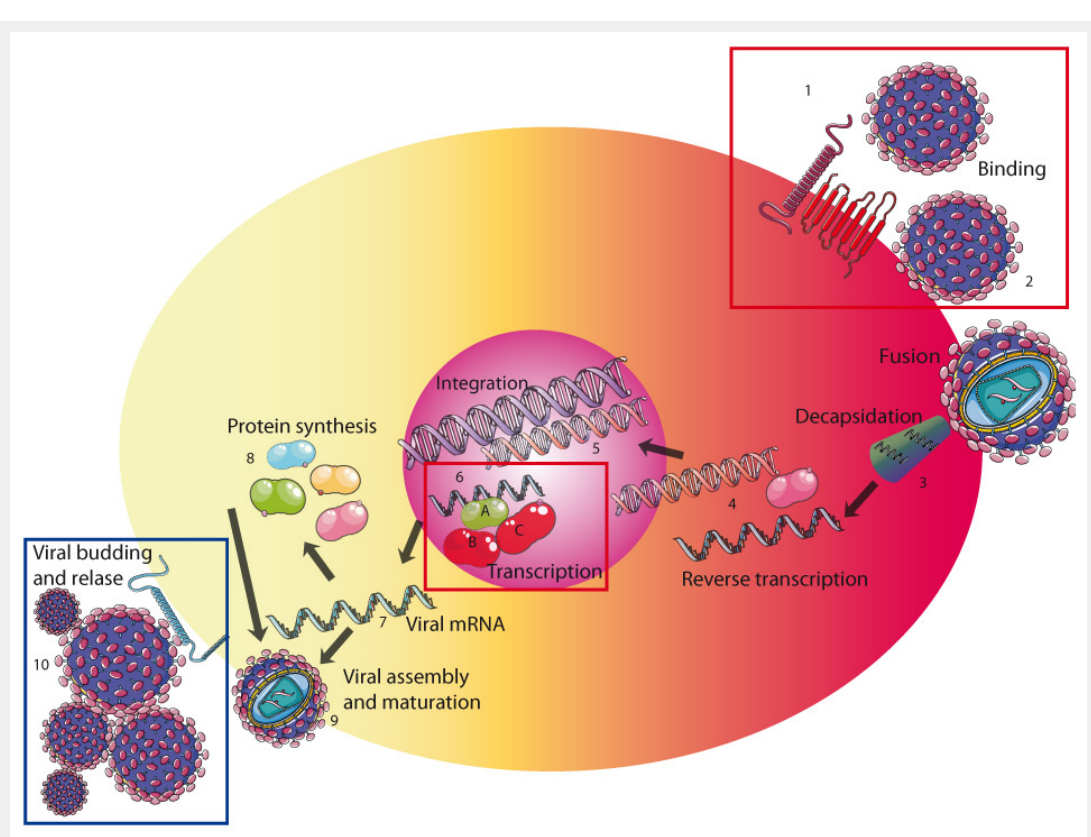
HIV-1 needs critical host factors for efficient replication. HIV binds to the HIV receptor complex of the human CD4 cell-surface molecule and a co-receptor, either CCR5 or CXCR4, via the HIV envelope glycoprotein 120 (HIV env gp120). After conformational changes in the HIV env gp41, viral host cell membrane fusion occurs (2). The next steps are the decapsidation (3) and release of the HIV RNA from the virus particle. Reverse transcription generates a viral complementary DNA (cDNA) based on the viral RNA template and using HIV’s own reverse transcriptase (4). Once the cDNA is generated, the preintegration complex (PIC) is assembled, nuclear trafficking and integration of the viral cDNA into the host genomic DNA follow (5). Efficient transcription and elongation require formation of P-TEFb (positive transcription elongation factor b) consisting of Tat (6A), human cyclin-dependent kinase 9 (CDK-9) (6B) and cyclin T1 (6C), which binds to the nascent HIV transcripts. Fully or partially spliced HIV mRNA (7) is used to translate viral proteins. Unspliced HIV RNA is packaged into newly generated virions. Assembly of HIV proteins and RNA and budding take place at the cellular membrane (9). HIV release is inhibited by murine tetherin at the cellular membrane because murine tetherin is insensitive to the viral protein Vpu, which inhibits human tetherin by directing its proteasomal degradation (blue frame). Human host factors critical for HIV replication are CD4, CCR5, CXCR4 and cyclin T1 (red frame). Additional human specific factors probably